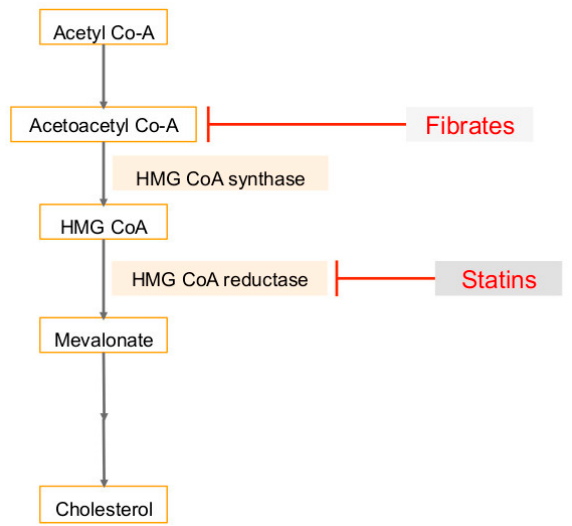
Figure 3. Mevalonate pathway as an important metabolic pathway: The mevalonate pathway is regulated by HMG CoA reductase (HMGCR), and this enzyme is targeted by statins to decrease plasma cholesterol. Fibrates target the mevalonate pathway by inhibiting acetoacetyl coenzyme A. This reverses the effects of cholesterol to inhibit cell proliferation and trigger apoptotic parameters. Downregulating the pathway also suppresses production of farnesyl pyrophosphate and geranylgeranyl phosphate to inhibit the invasive properties of cancer cells. T-bars in red denote inhibition.